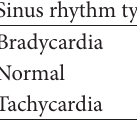
Table 1: Thresholds for detection of stress state. Variable